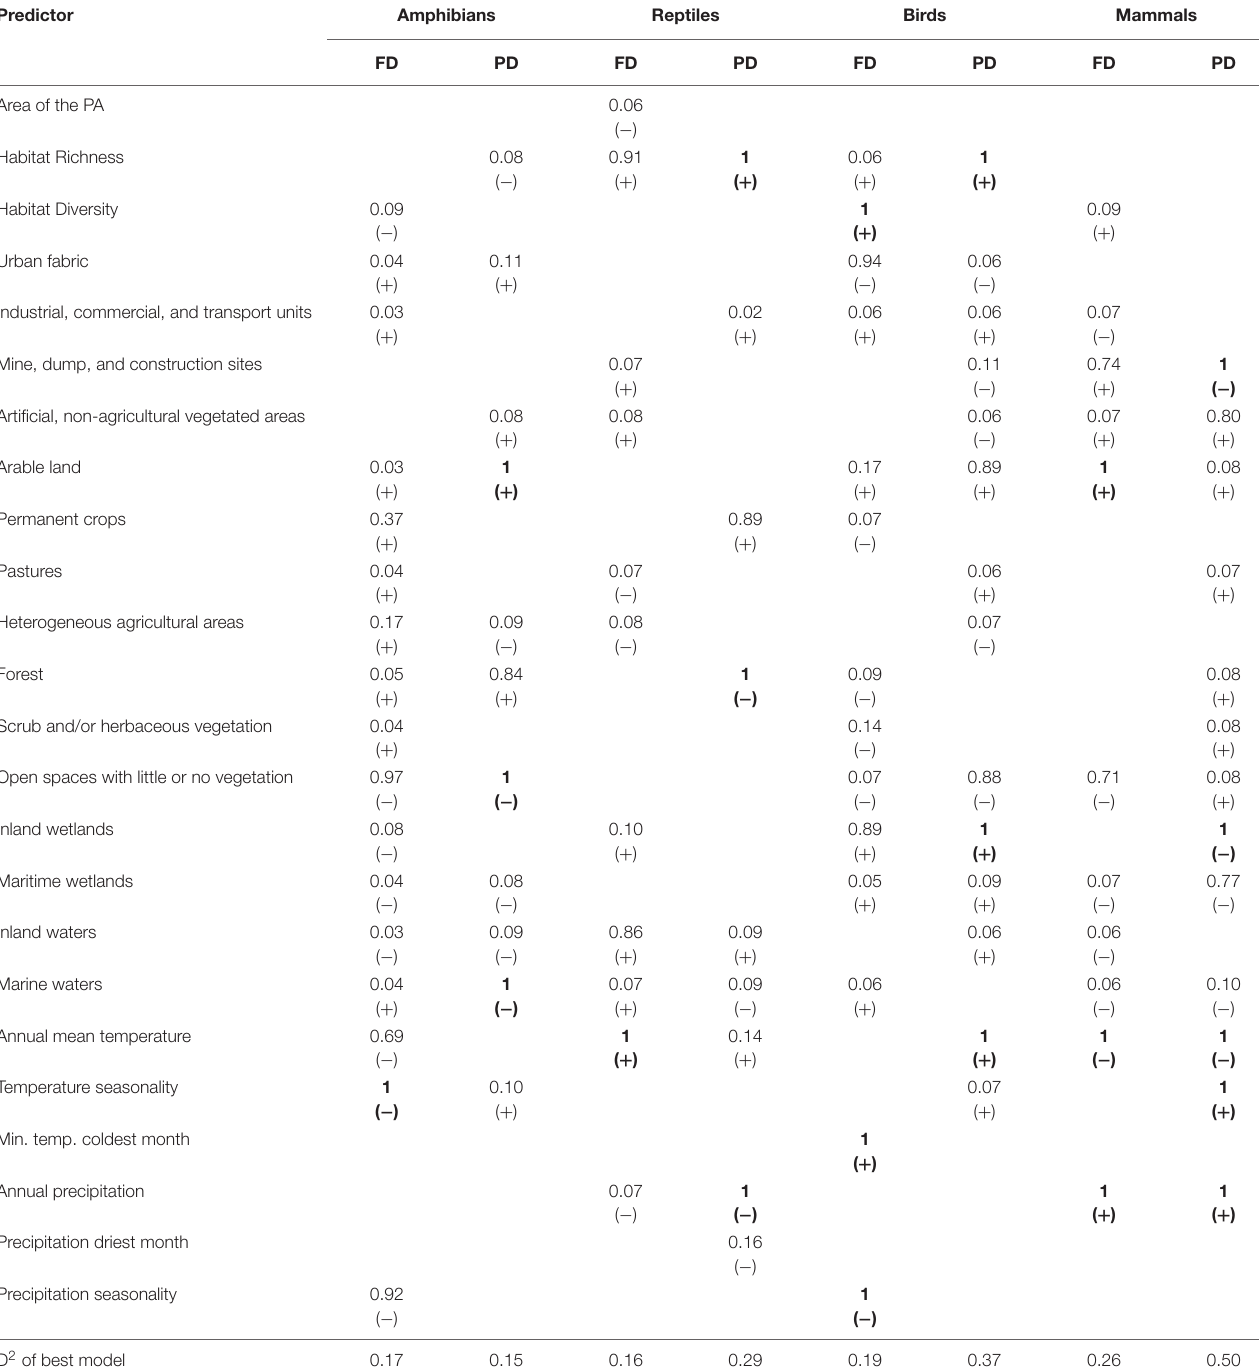
TABLE 2 | Importance value of each predictor after the model averaging of the most substantially supported GLM models (i.e., with (cid:49) AICc < 2) quantifying how well protected areas (PAs) represent the functional (FD) and phylogenetic (PD) regional diversities of four tetrapod groups (see Materials and Methods). Predictor Amphibians Reptiles Birds